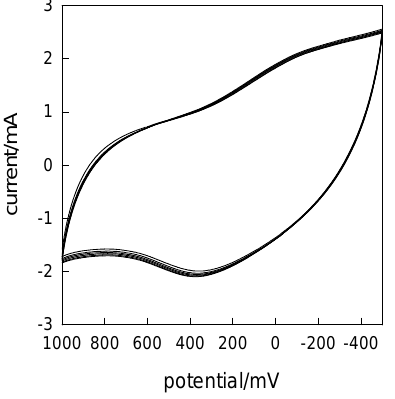
Figure 9. Eleven cyclic voltammograms obtained with the CLTNPE in 0.1 mmol.L -1 of NA. Scan rate: 50 mV/s